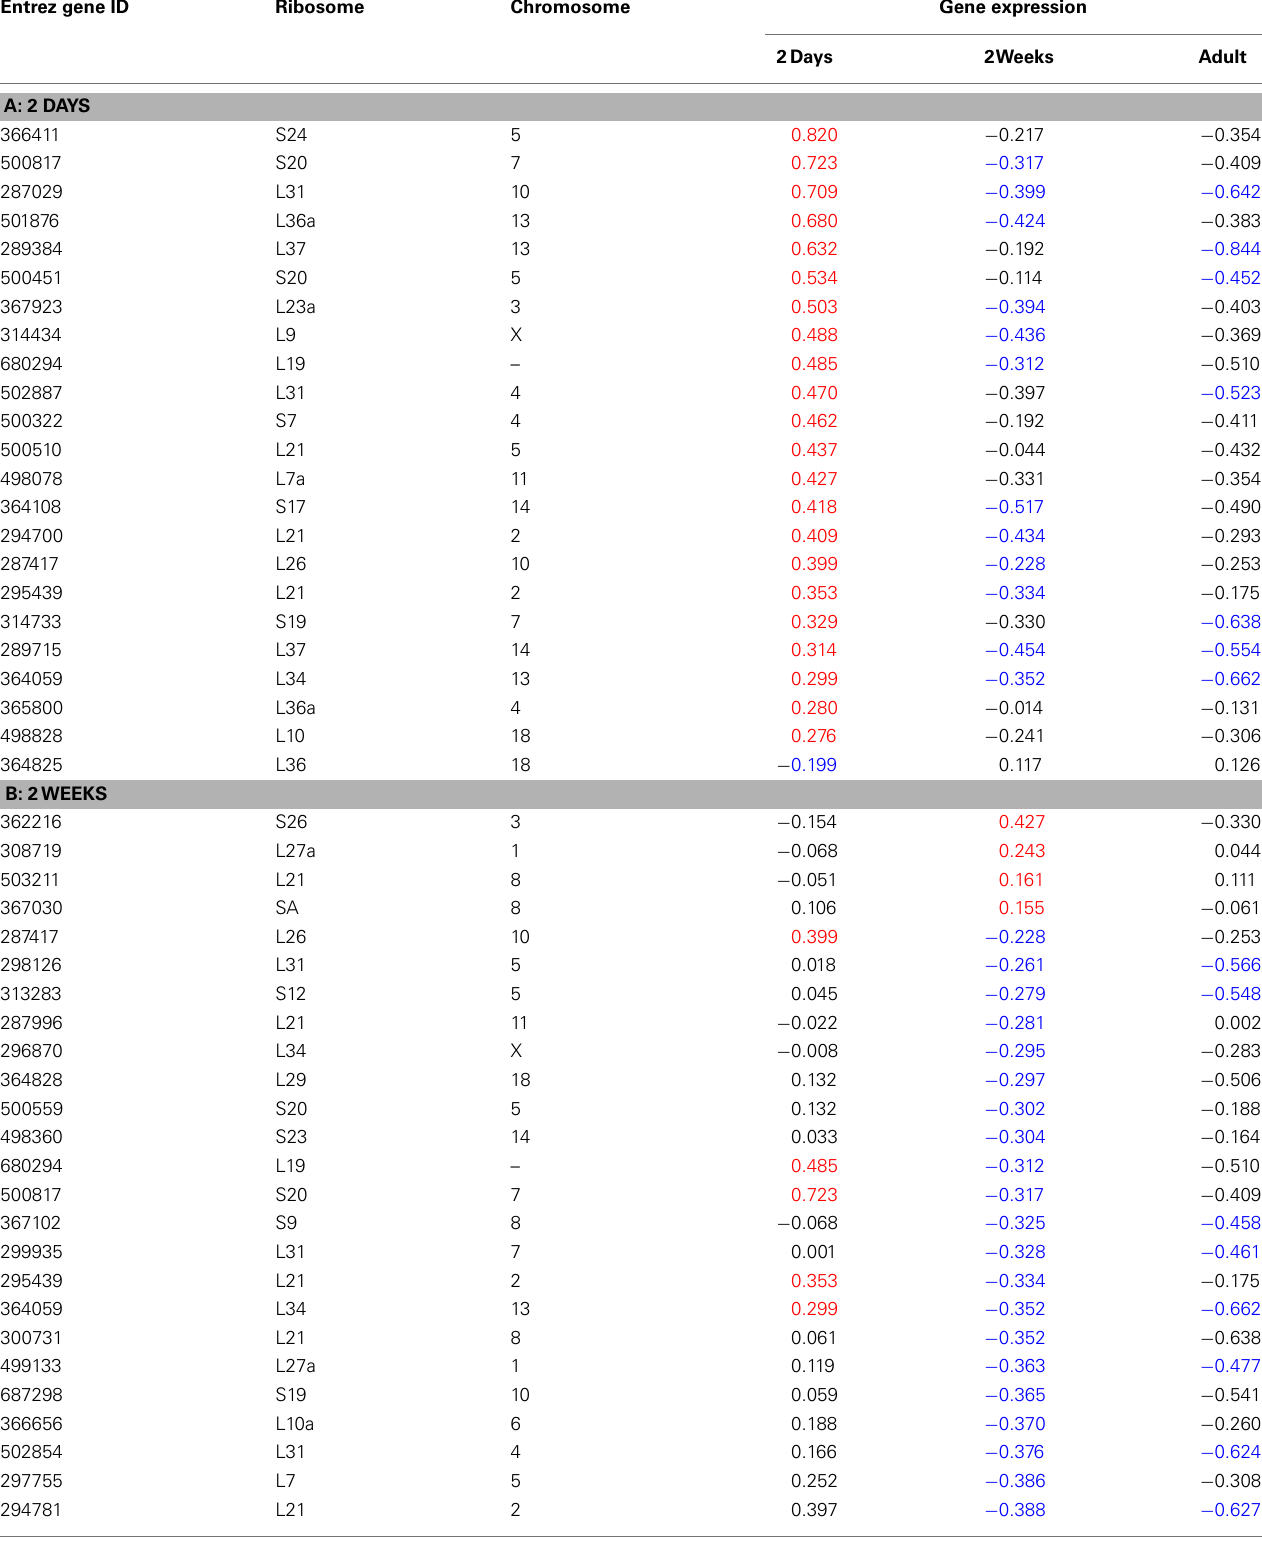
TableA2 | Ribosomal protein genes in kidneys of FHH males differentially expressed by molsidomine (FM, 2days and 2weeks) or after perinatal molsidomine (FM, adult) vs. controls